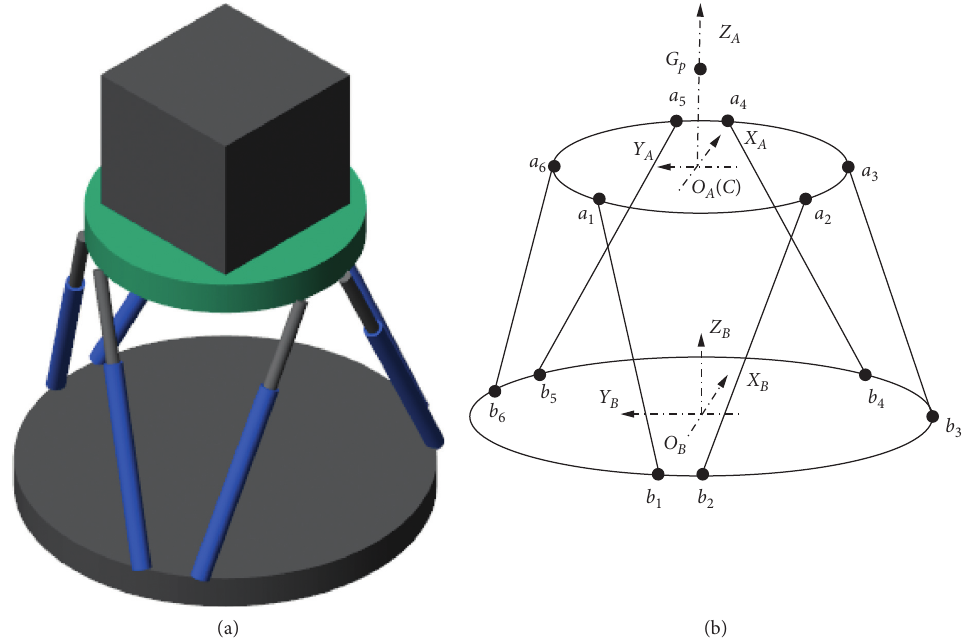
Figure 1: Schematic of the Stewart robot. (a) Simplified structure. (b) Mathematical